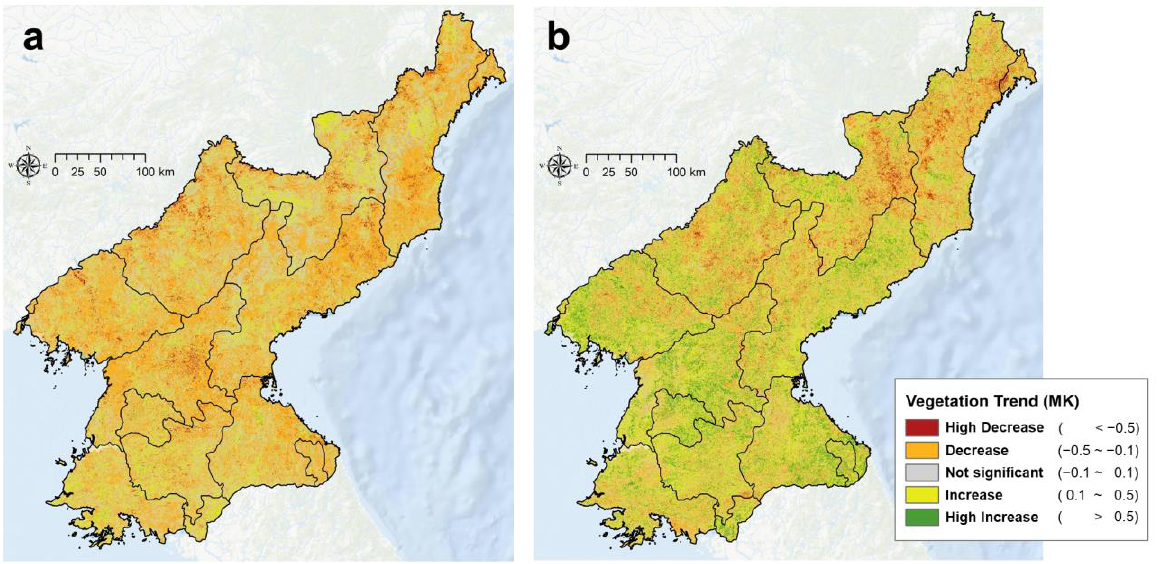
Figure 4. Spatiotemporal vegetation trend of North Korea: ( a ) deforestation period (1986 – 2000) and ( b ) afforestation period (2012 – 2021). Table 1. Statistics of Theil – Sen slope on deforestation and afforestation period in each local province. Deforestation Period Afforestation Period Province